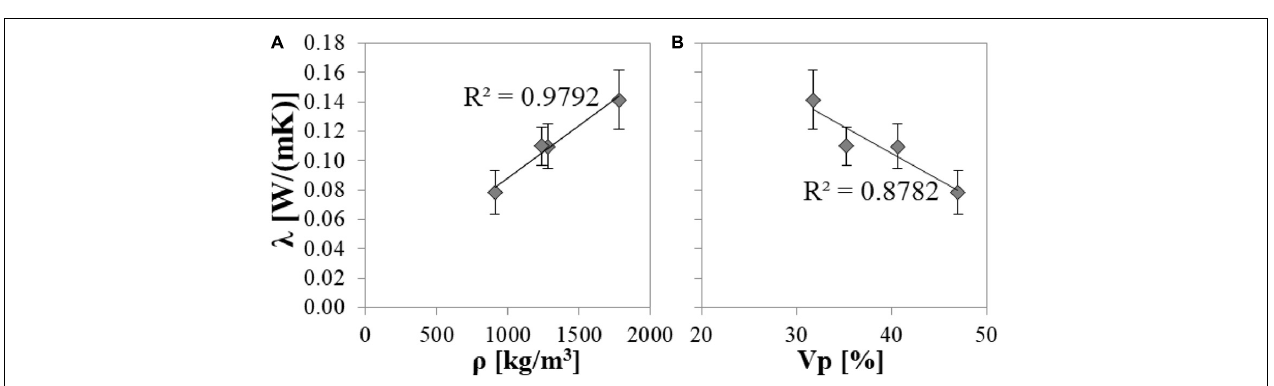
FIGURE 7 | Relation between (A) thermal conductivity and density and (B) thermal conductivity and total pore volume.